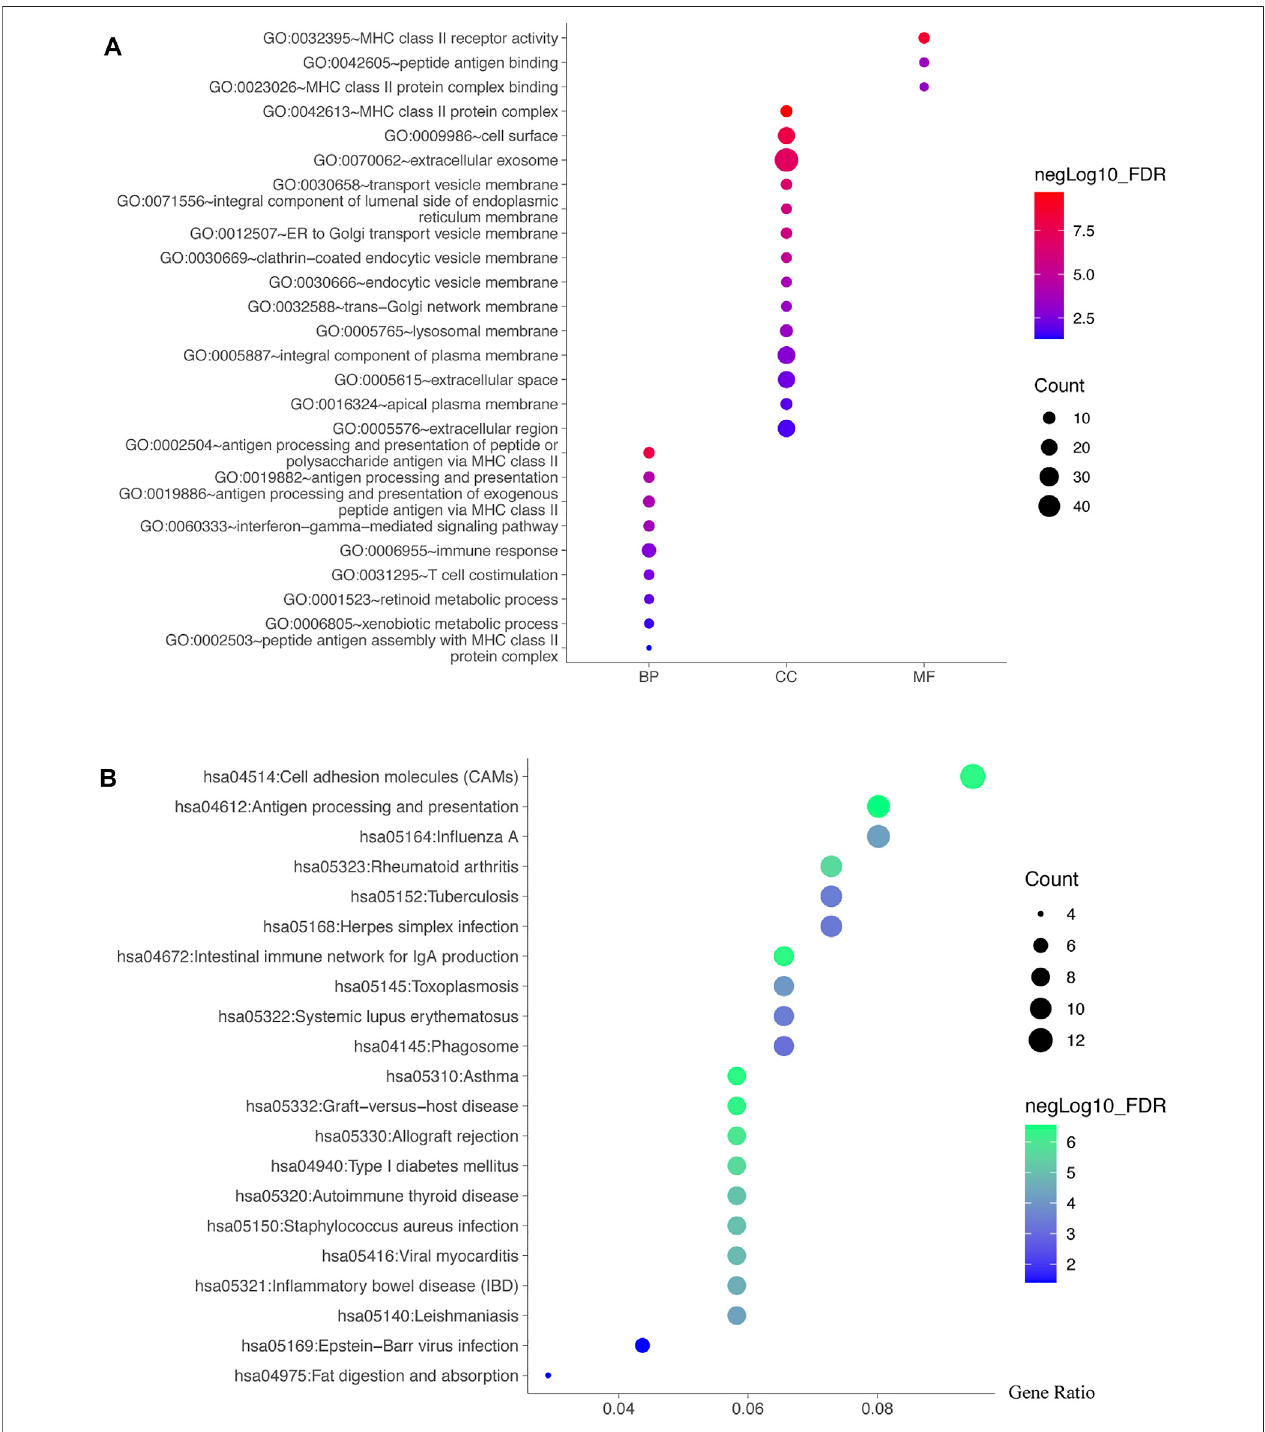
FIGURE7| PotentialfunctionsandpathwaysofTRIB3andFABP1byGOandKEGGanalyses.Thegenessharedbythetwoco-expressionanalyseswereusedfor further GO (A) and KEGG (B) analyses.